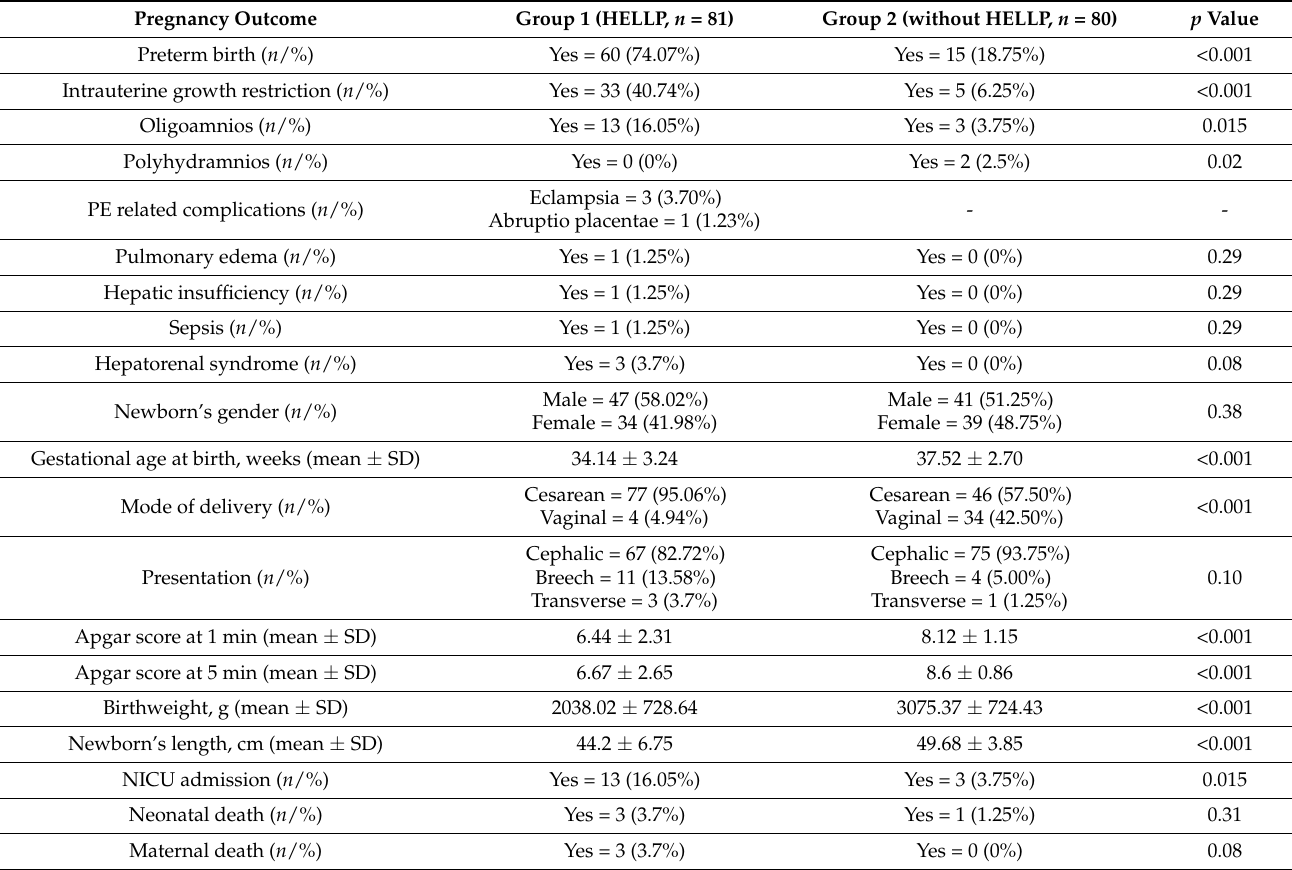
Table legend: PE—preeclampsia; SD—standard deviation; g- grams; NICU—neonatal intensive care